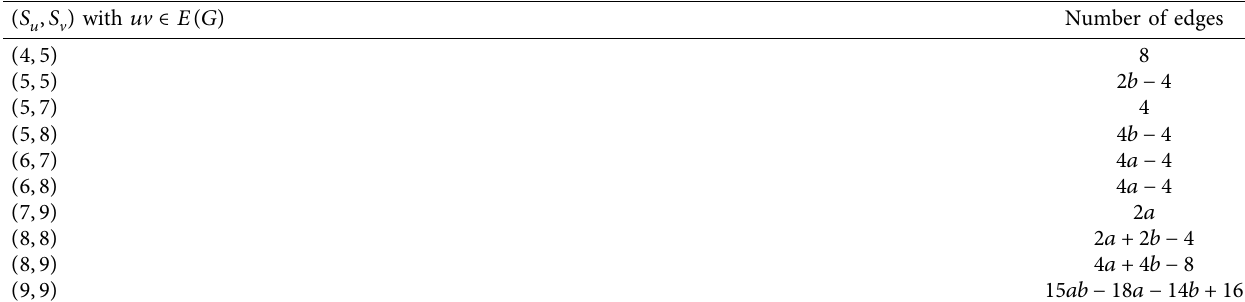
Table 11: Edge partition of T 3 [ a, b ]